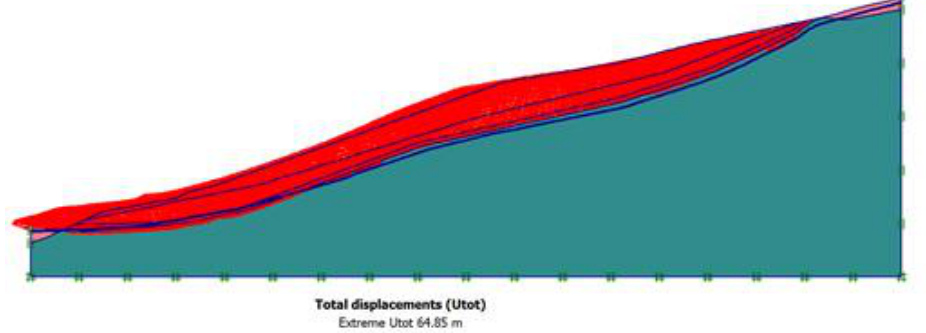
Fig. 12. Contour of displacements occurred during slippage on bedrock